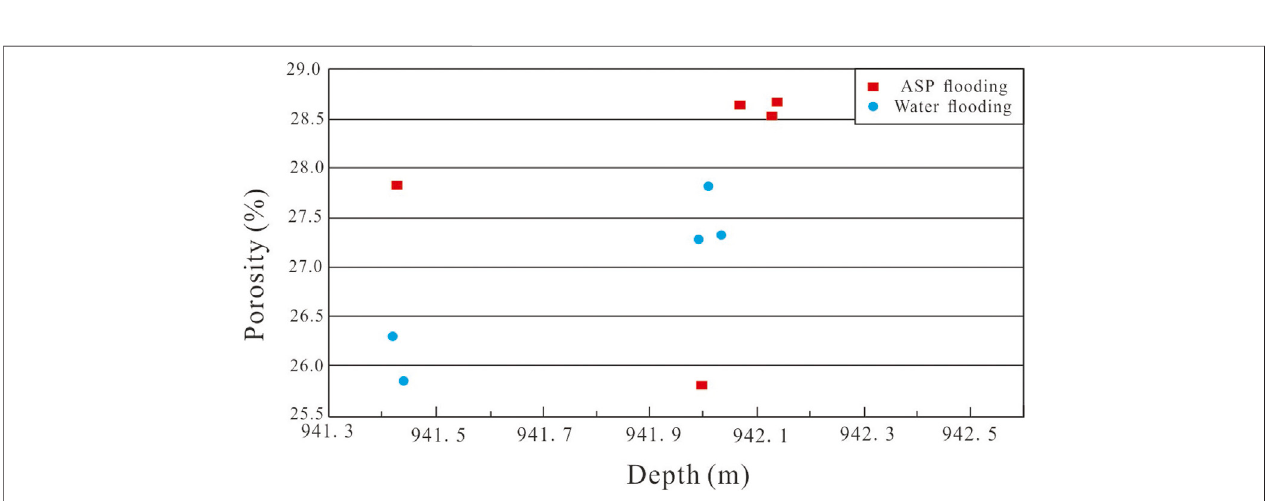
FIGURE 8 | Variation characteristics of porosity before and after ASP fl ooding.